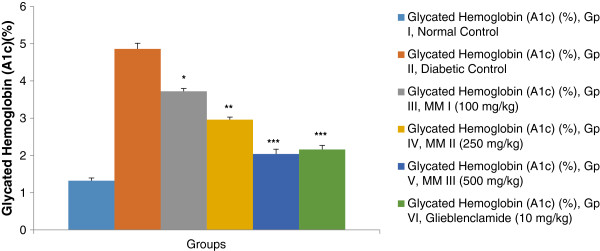
Effect of Melastoma malabathricum Linn. (MM) on level of glycated hemoglobin (A1c)(%) at different concentrations on STZ induced diabetic rats, compared to standard drug Glibenclamide; values are mean ± SEM; n = 6; *P < 0.05; **P < 0.01; ***P < 0.001; P > 0.05 is considered as non-significant (ns).